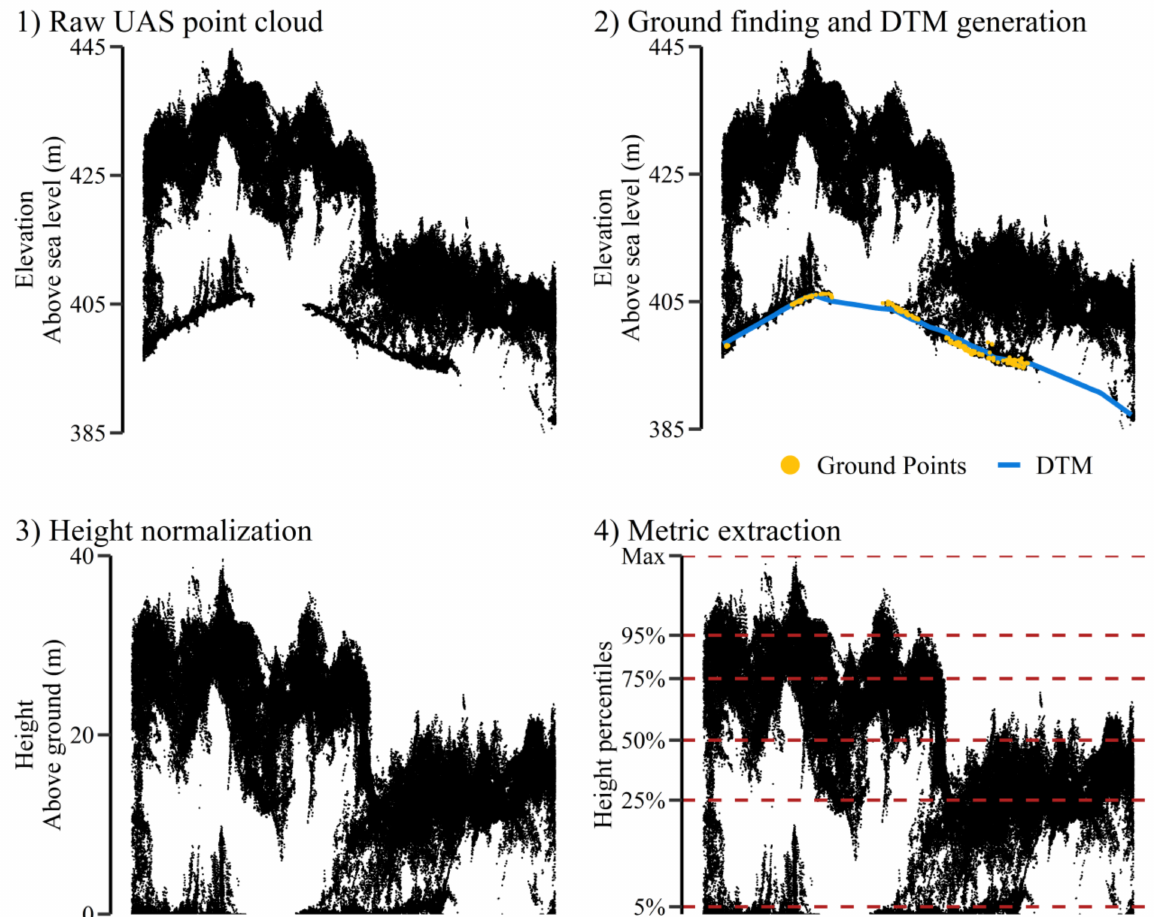
Figure 2. Point cloud processing